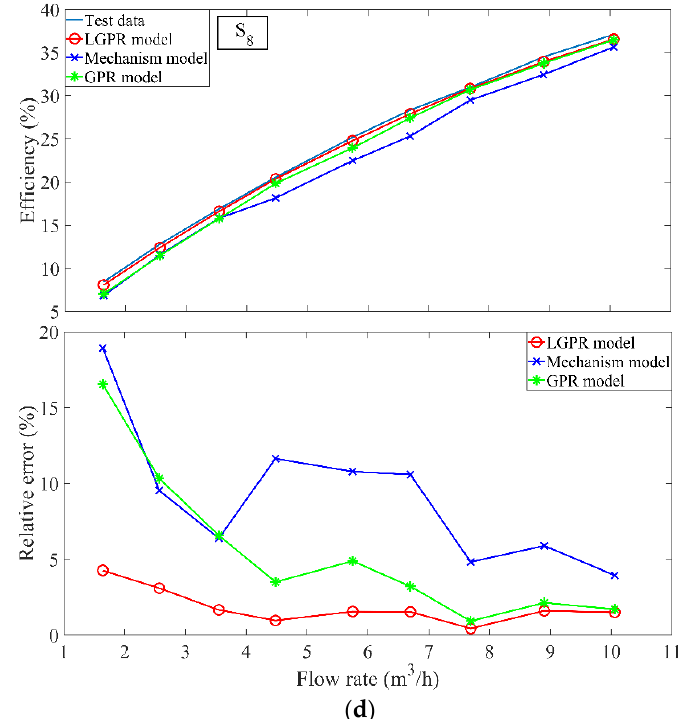
Figure 8. ( a ) The LGPR model and the GPR model prediction results and relative error of the small-flow stage of the test set S 2 ( b ) The LGPR model and the GPR model prediction results and relative error of the small-flow stage of the test set S 4 ( c ) The LGPR model and the GPR model prediction results and relative error of the small-flow stage of the test set S 7 ( d ) The LGPR model and the GPR model prediction results and relative error of the small-flow stage of the test set S 8 .